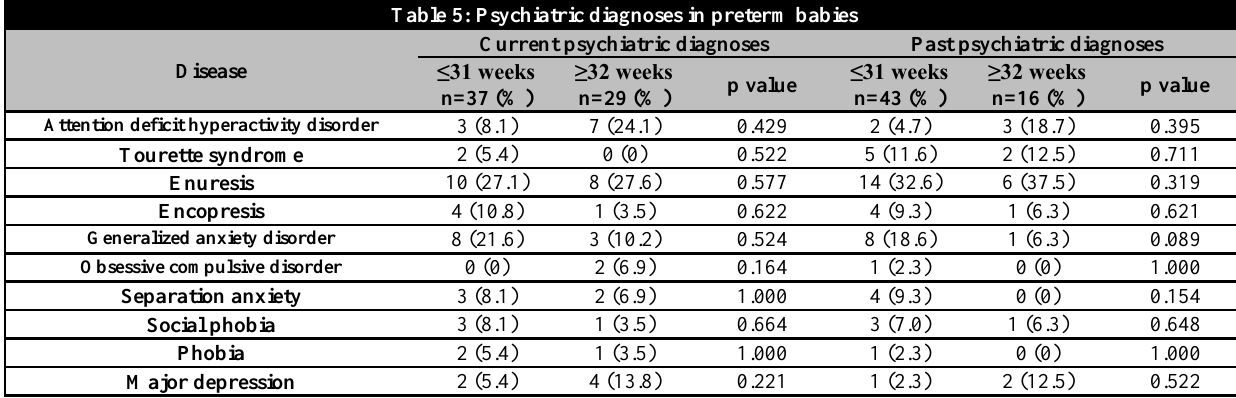
Table 5: Psychiatric diagnoses in preterm babies Current psychiatric diagnoses Past psychiatric Disease